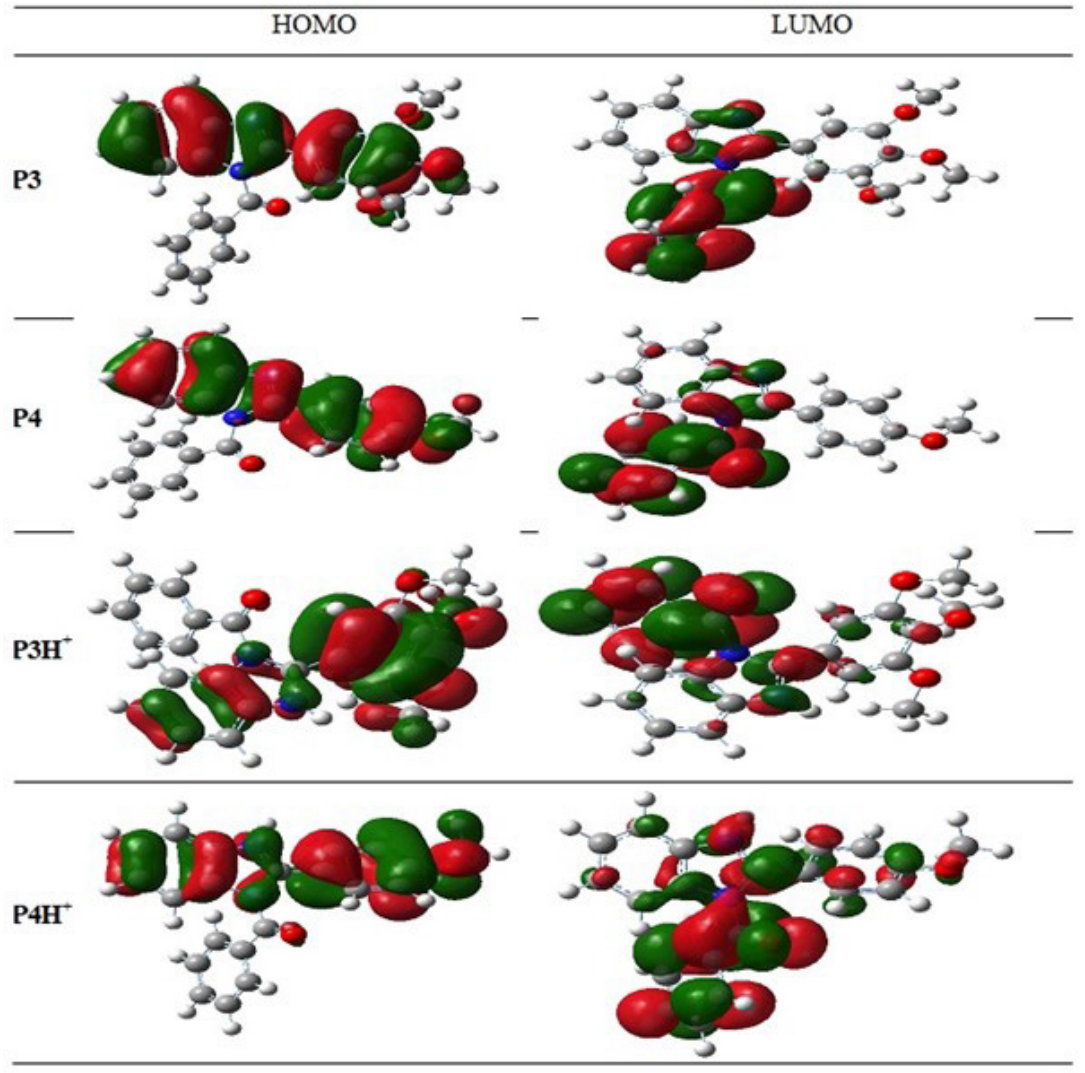
Figure 14. HOMO and LUMO boundary molecular orbitals for the neutral and protonated forms of P3 and